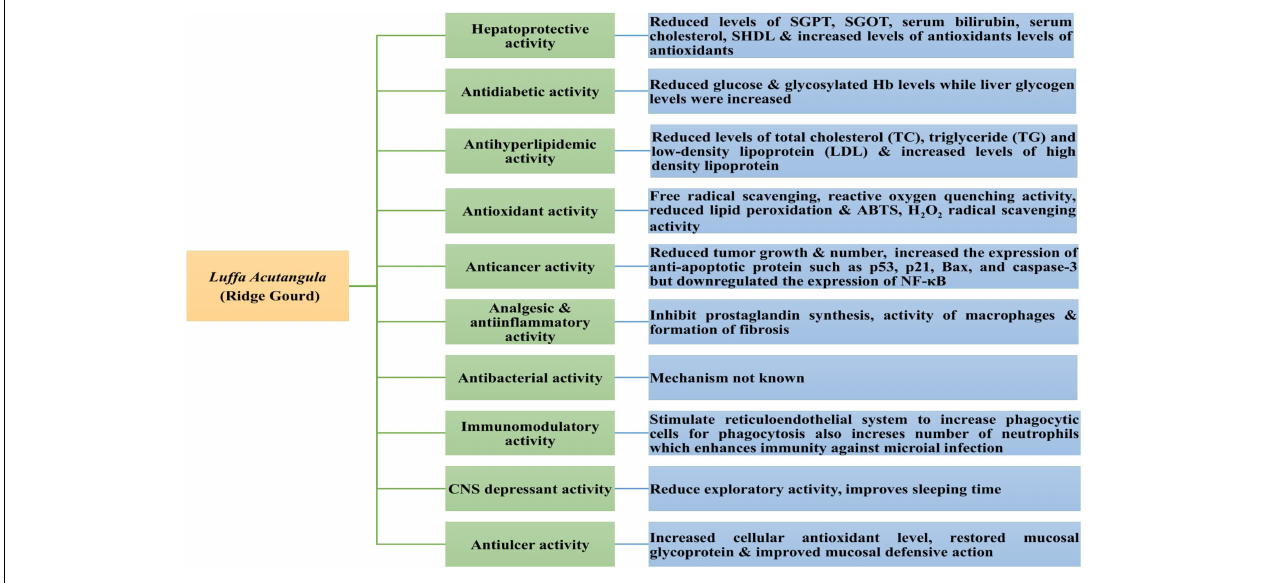
FIGURE 7 | Possible mechanisms for pharmacological